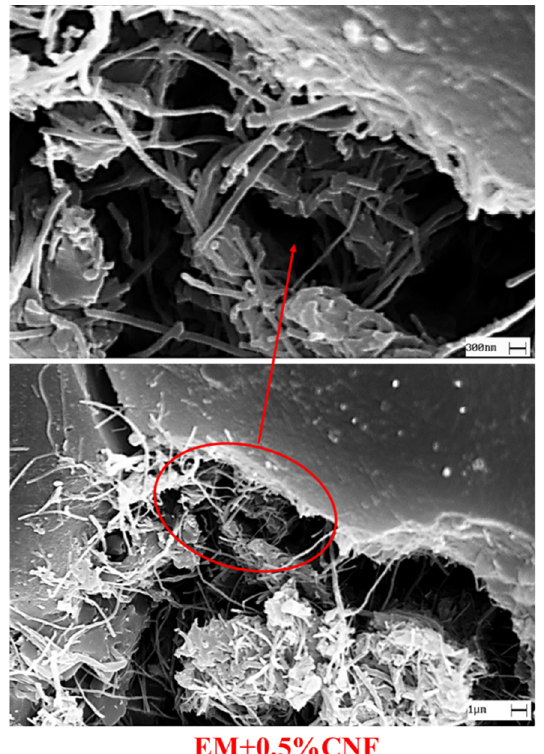
Figure 8. SEM images at different magnifications of the EM + 0.5%CNF sample.